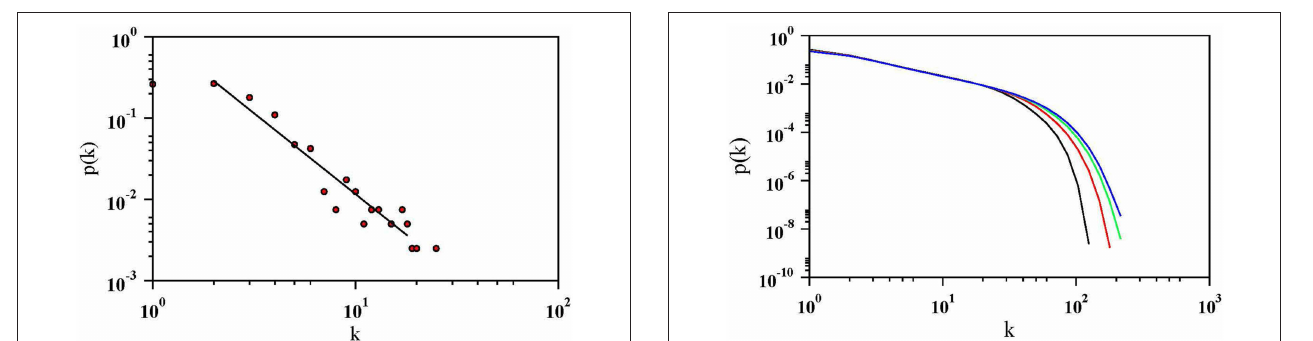
FIGURE 7 | Log–log plot of the degree distribution for the real desert rose sample. A power law p ( k ) ∼ k − α with α = 2 . 0 has been added as a guide to the eye.